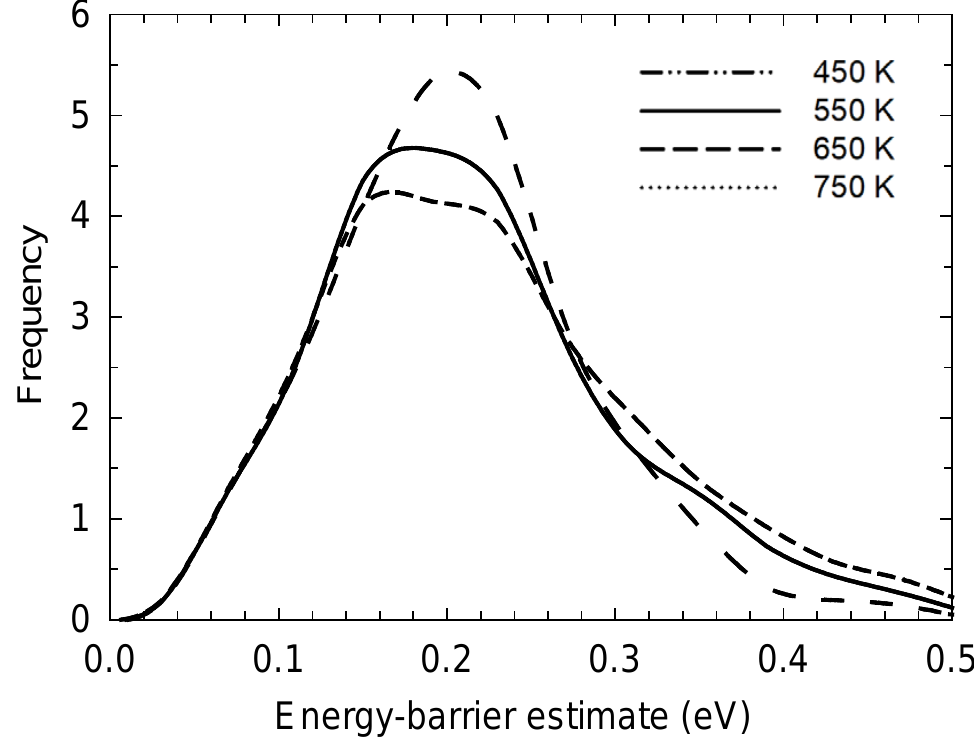
Figure 4. Normalised probability distributions of each reaction’s estimated potential-energy barrier, as sampled from consideration of participating iodine atoms’ interaction-energy variation immediately before and at the highest interaction-energy point during bond-exchange events. The move towards lower potential-energy barriers with increasing temperature is evident.